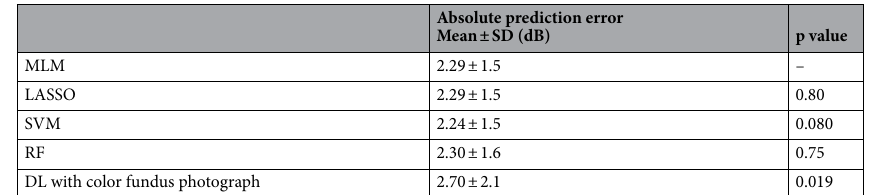
Table 3. The absolute prediction error with each method. p value was calculated against MLM. SD standard deviation, MLM multivariate linear regression, LASSO least absolute shrinkage and selection operator regression, SVM support vector machine, RF random forest, DL deep